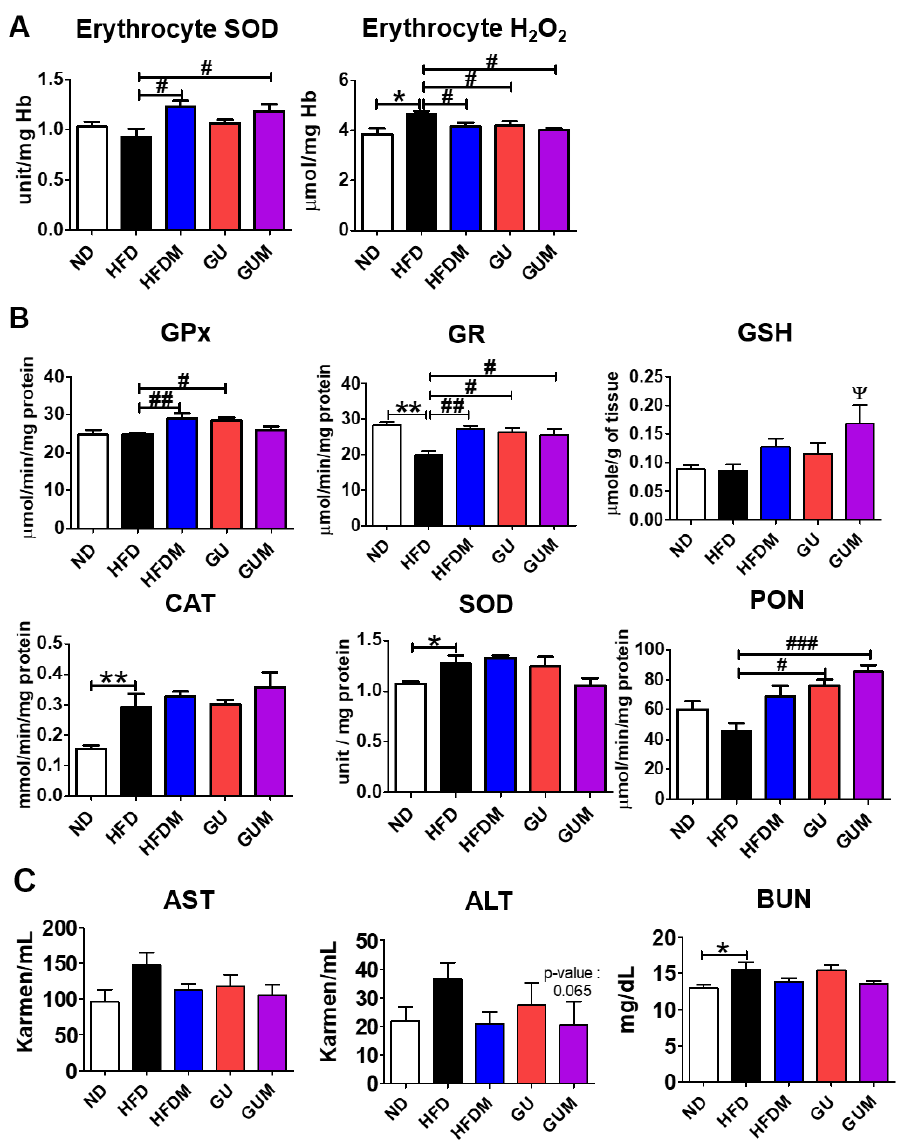
Figure 7. Effect of metformin, G. uralensis Fischer, and their combination after 16 weeks on erythrocyte H₂O₂ production and SOD activity ( A ); hepatic antioxidant enzyme activities (CAT, SOD, GPx, GR, and PON) ( B ), and plasma AST, ALT, and BUN levels ( C ) in C57BL/6J mice fed a high-fat diet. Data are presented as the mean ± SEM. Significant differences between HFD and ND are indicated: * p < 0.5, ** p < 0.01. When compared one-to-one, there were significant differences between GUM and HFD: Ψ p < 0.05. Significant differences among the high-fat diet groups are indicated: # p < 0.05, ## p < 0.01, ### p < 0.001. When compared one-to-one, there were significant differences between the HFDM and HFD groups ( p < 0.05). ND, normal diet (AIN-93G 16 kcal% fat); HFD, high-fat diet (60 kcal% fat); HFDM, HFD + metformin 50 mg/kg; GU ( G. uralensis Fischer), HFD + GU 0.015%; GUM, HFD + GU 0.015% + metformin 50